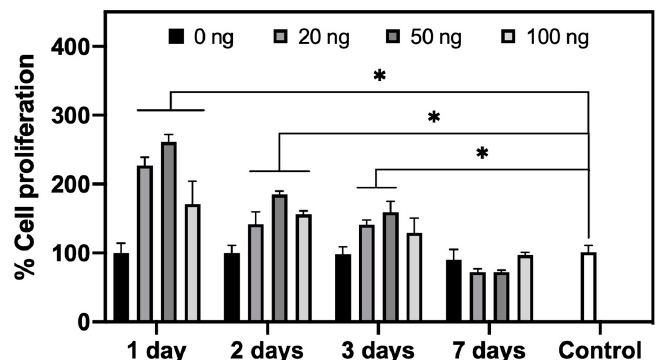
Figure 8. Bioactivity of released vascular endothelial growth factor (VEGF) in Endothelial cell medium (ECM) culture medium enriched with 0.1% FCS at 37 °C based on cell proliferation using Human Umbilical Vein Endothelial Cells (HUVECs) cells (* p < 0.05). The test was repeated twice and each in duplicate ( n = 4). Table 1. Concentration of released VEGF within 7 days in ECM culture medium enriched with 0.1% FCS at 37 °C. Release